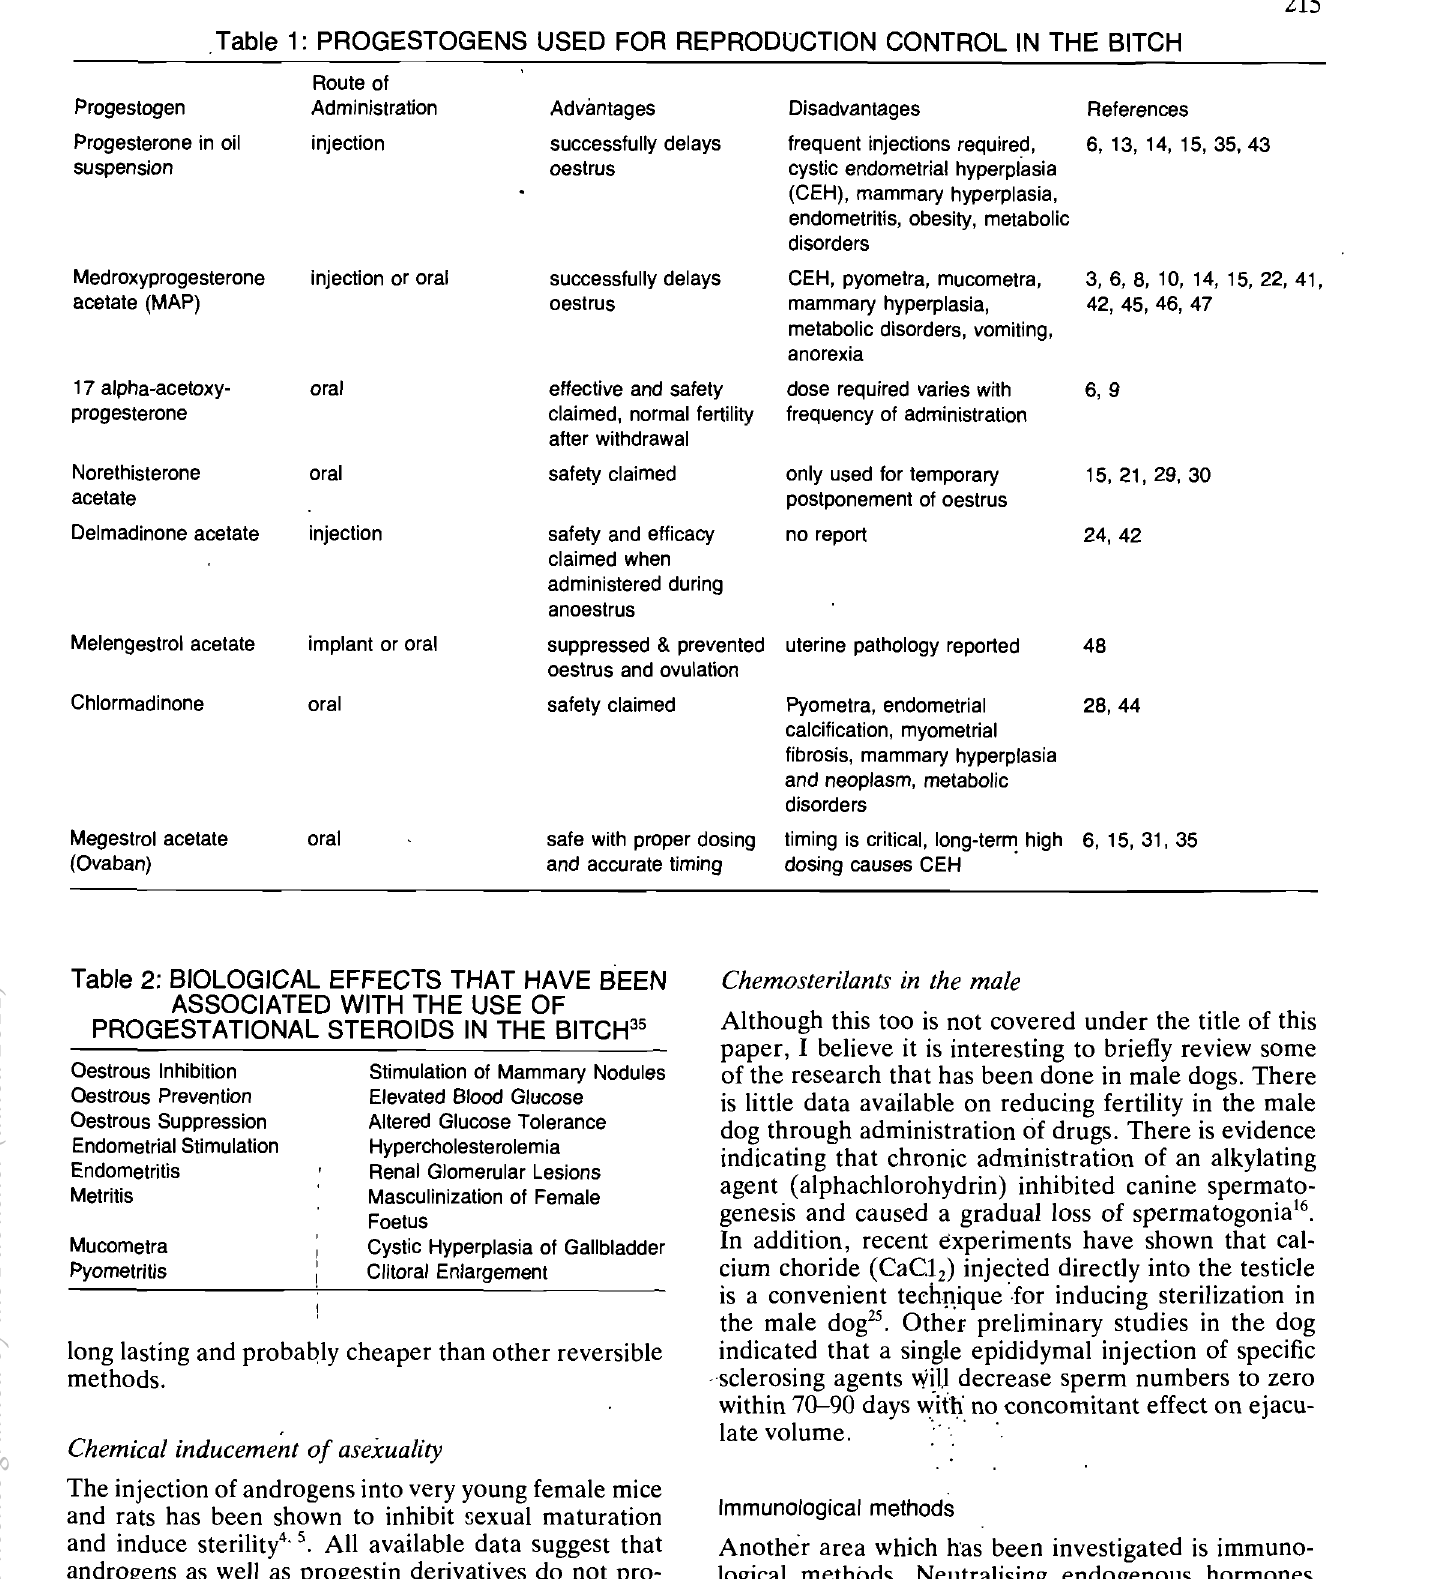
Table 1: PROGESTOGENS USED FOR REPRODUCTION CONTROL IN THE BITCH Route of Progestogen